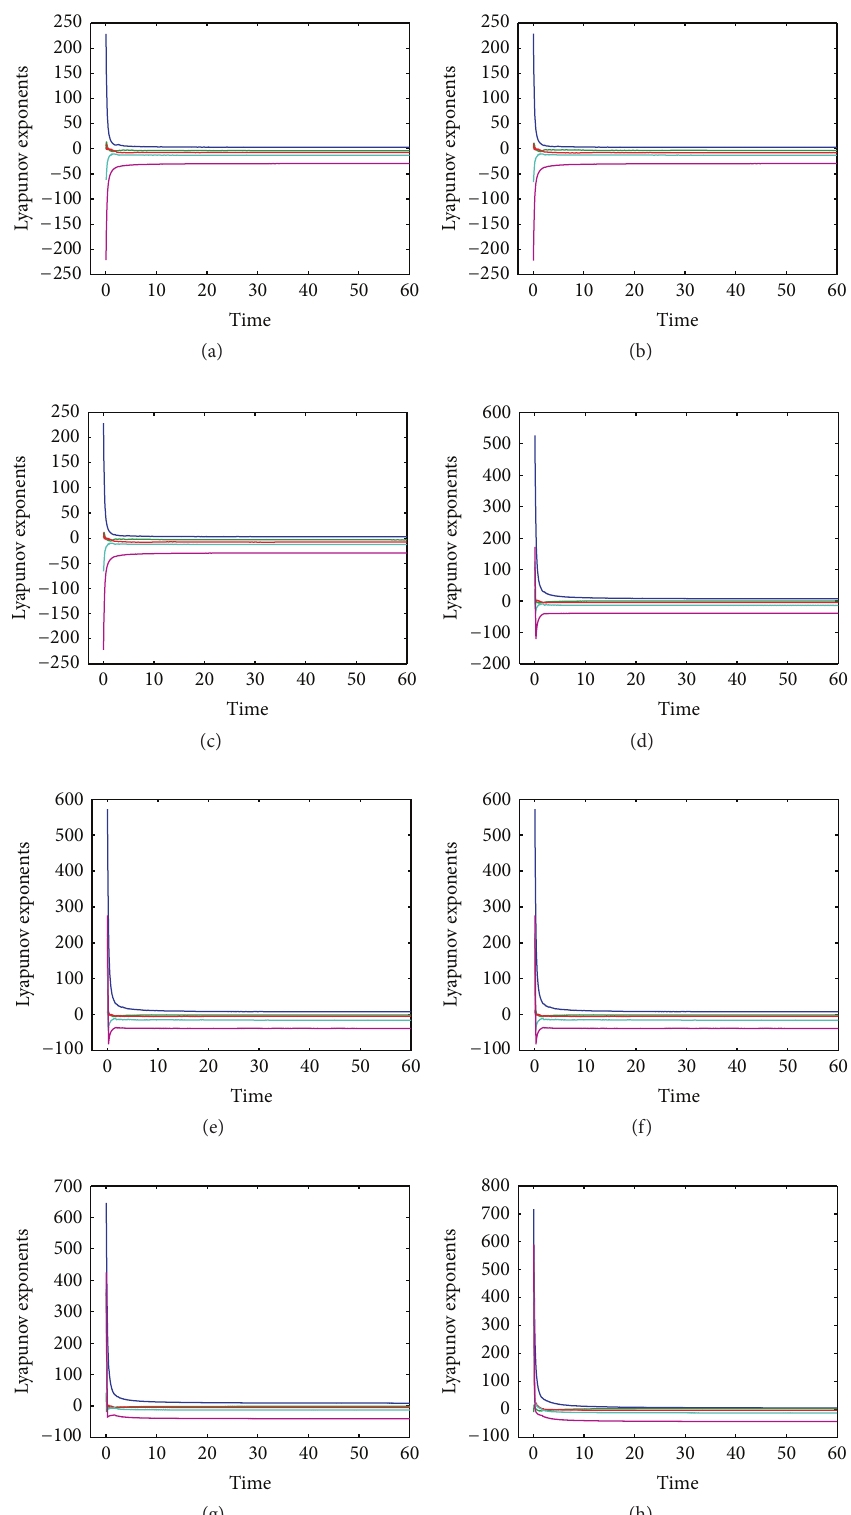
Figure 7: Dynamics of Lyapunov exponents for (a) 𝑅 = 46.37 , (b) 𝑅 = 48 , (c) 𝑅 = 250 , (d) 𝑅 = 260 , (e) 𝑅 = 300 , (f) 𝑅 = 360 , (g) 𝑅 = 400 , and (h) 𝑅 = 500 for the case where Le = 0.1 , 𝑅 𝑠 = 15